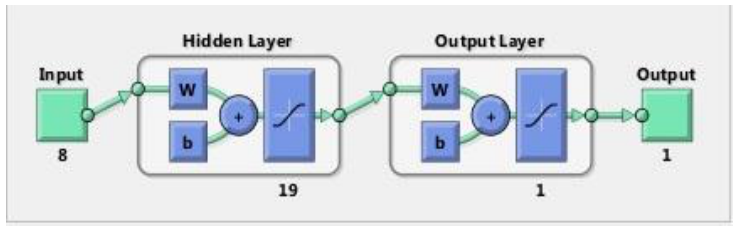
Figure 3 Structure of the Best Model